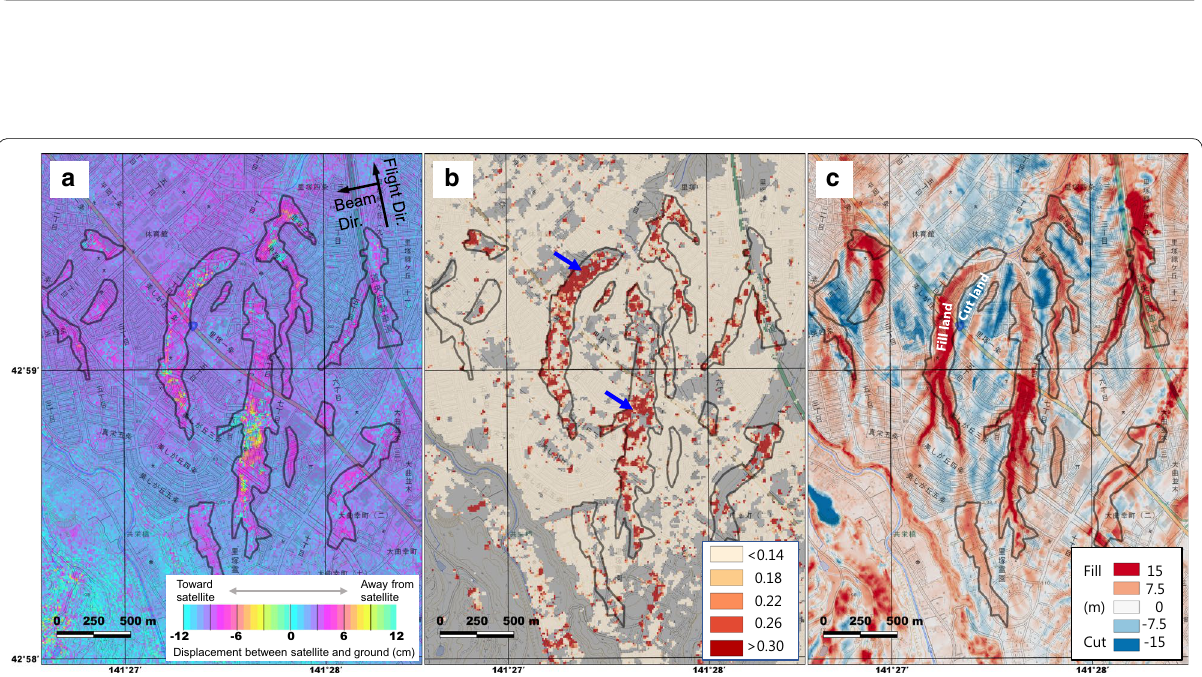
Fig. 10 SAR interferogram ( a ), normalized coherence-change map ( b ), and change in topography ( c ) in the southern part of the city of Sapporo showing liquefaction. a SAR interferogram, using image pair 4 (Table 1). Black lines indicate areas where subsidence and surface changes were estimated using Fig. 10a, b. b Normalized coherence change of SAR image pairs 2 and 4. Gray shading indicates areas where coherence before the earthquake was < 0.5. Blue arrows indicate areas experiencing significant sediment-related damage as interpreted from aerial photographs. Black lines are the same as in a . c Change in topography due to cut-and-fill activity as detected in aerial photographs. Black lines are the same as in